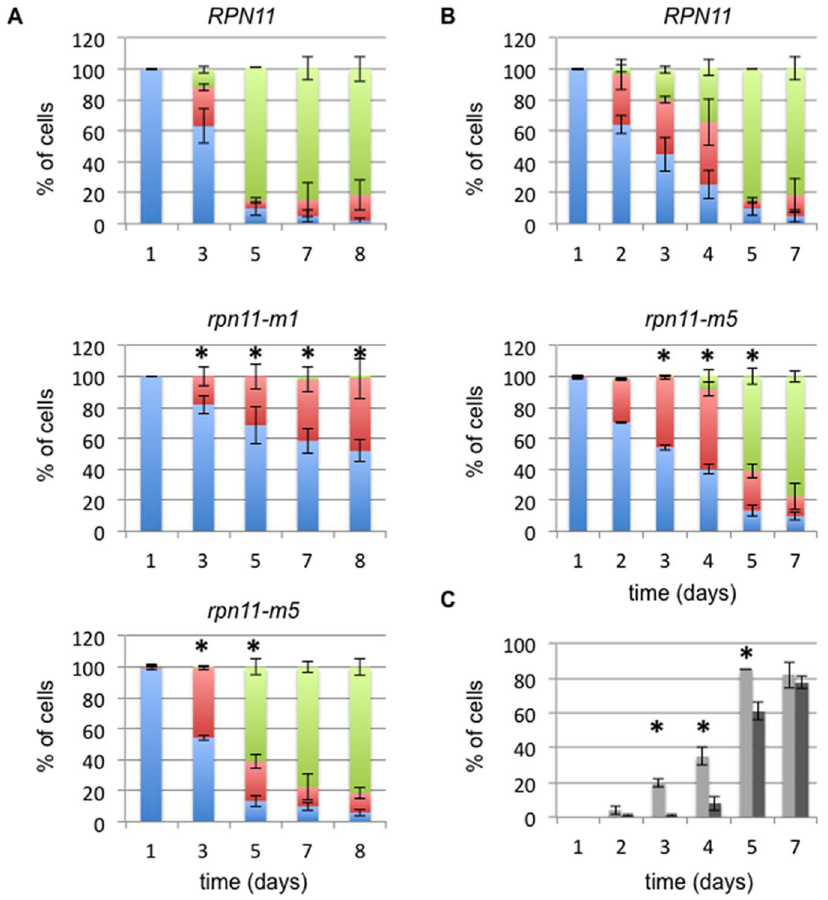
Figure 4. Localization of Rpn5-GFP in proteasome mutants defective in 26S assembly/stability. ( A ) Wild type, rpn11-m1 and rpn11-m5 cells expressing Rpn5-GFP were grown in YPDA medium at 26 u C during 8 days. For each time point (day), the OD 600 nm was monitored, the survival rate performed (Figure S1) and the localization of Rpn5-GFP fluorescence was scored as nuclear (blue bar), at the nuclear periphery (red bar) or as cytosolic dots (green bar; n . 100 cells for each time point; two independent experiments; error bars report the differences between the two experiments). (*) indicate that the differences in the distribution of the Rpn5-GFP signal in the mutant cells are significant relative to the wild-type cells after statistical analyses (Pearson’s chi-squared test, P values , 0.05). ( B ) Wild type and rpn11-m5 cells producing Rpn5-GFP were grown in YPDA medium at 26 u C during 7 days. Localization of Rpn5-GFP was scored as in (A) but every day from day 1 to day 5 and at day 7. ( C ) Comparison of Rpn5- GFP-cytosolic foci apparition between the wild type (grey) and the rpn11-m5 mutant (black) for each day. Error bars represent the difference observed between the two experiments and (*) indicates that the difference between the two strains is significant (Fisher’s exact test, P values , 0.05).